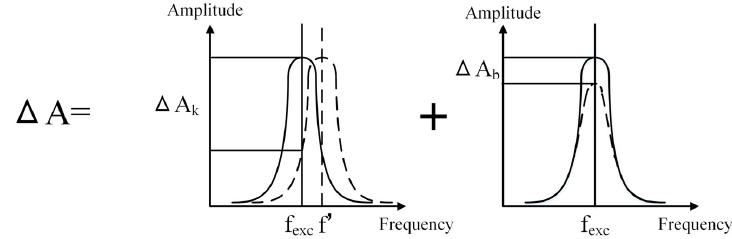
Figure 14. The division of the amplitude change in AM mode.